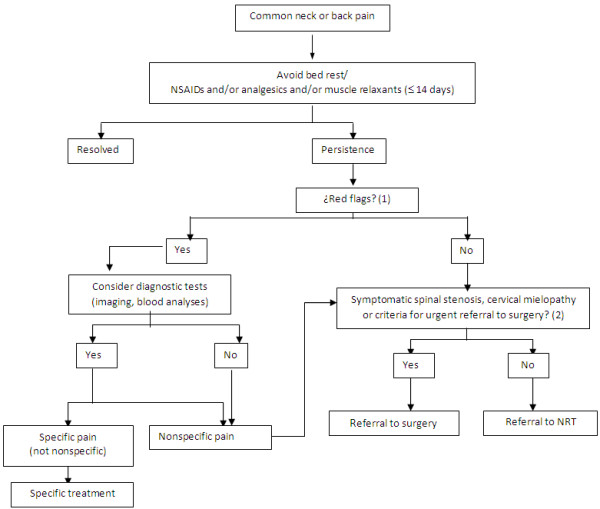
Referral protocol for NRT intervention [[34],[40],[41]].